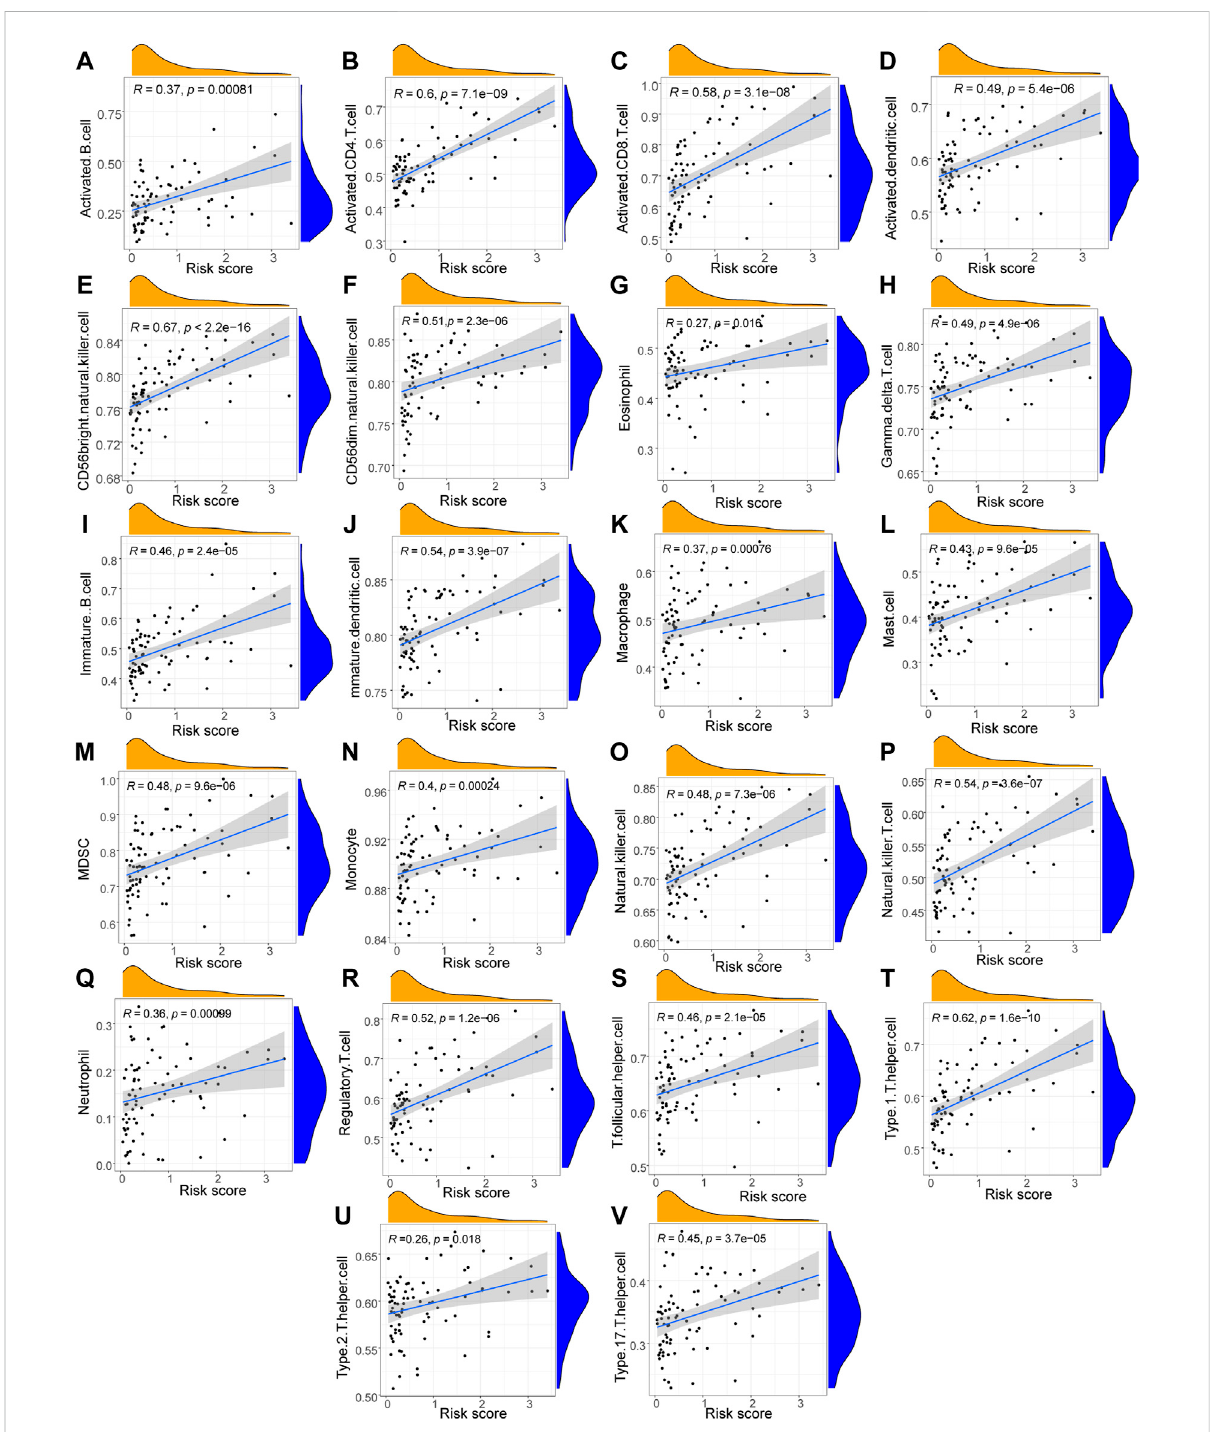
FIGURE 6 Correlation analysis between immune cells and Riskscores. (A – V) The scatter plot of the correlation analysis results between the LASSO model risk score and the in fi ltration abundance of immune cell including Activated B cells (A) , Activated CD4 T cells (B) , Activated CD8 T cells (C) , Activated dendritic cells (D) , CD56 bright natural killer cells (E) , CD56dim natural killer cells (F) , Eosinophils (G) , Gamma delta T cells (H) , Immune B cells (I) , Maturedendriticcells (J) ,Macrophages (K) ,Mastcells (L) ,MDSCs (M) ,Monocytes (N) ,Naturalkillercells (O) ,NaturalkillerTcells (P) ,Neutrophils (Q) , Regulatory T cells (R) , T follicular helper cells (S) , Type1 T helper cells (T) , Type2 T helper cells (U) , Type 17 T helper cells (V) . The slope is the magnitude of thecorrelation, andthe p -valueindicatesthe level ofsigni fi cance. p ≥ 0.05, not statistically signi fi cant; p < 0.05, statistically signi fi cant; p < 0.01, highly statistically signi fi cant; p < 0.001, extremely statistically signi fi cant. The absolute value of the correlation coef fi cient (R) in the correlation scatter plot is above 0.8, which is a strong correlation; The absolute value between 0.5 and 0.8 is a moderate degree of correlation; The absolute value between 0.3 and 0.5 is weakly correlated; The absolute value below 0.3 is considered weak or